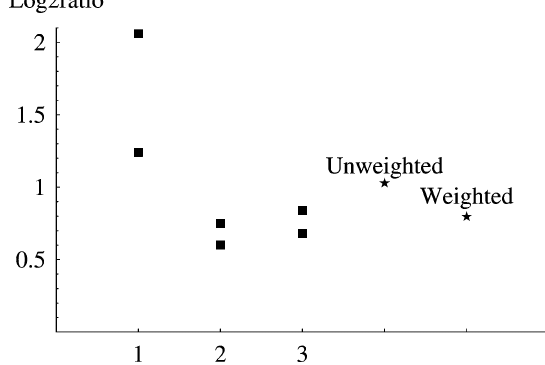
Fig. 5. Unweighted and weighted averages ( (cid:1) ) over three biological replicates ( (cid:1) ). Weight per biological replicate is inversely related to the standard deviation between the two technical replicates. We ob- serve that the unweighted average may be biased upwards due to the two inconsistent technical replicates of the first biological replicate.